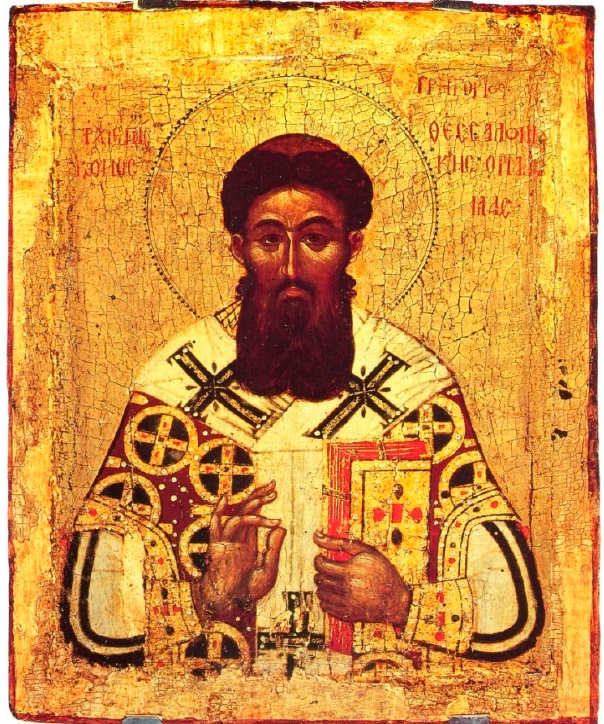
Figure 16. St. Gregory Palamas. A Byzantine Saint-Philosopher.